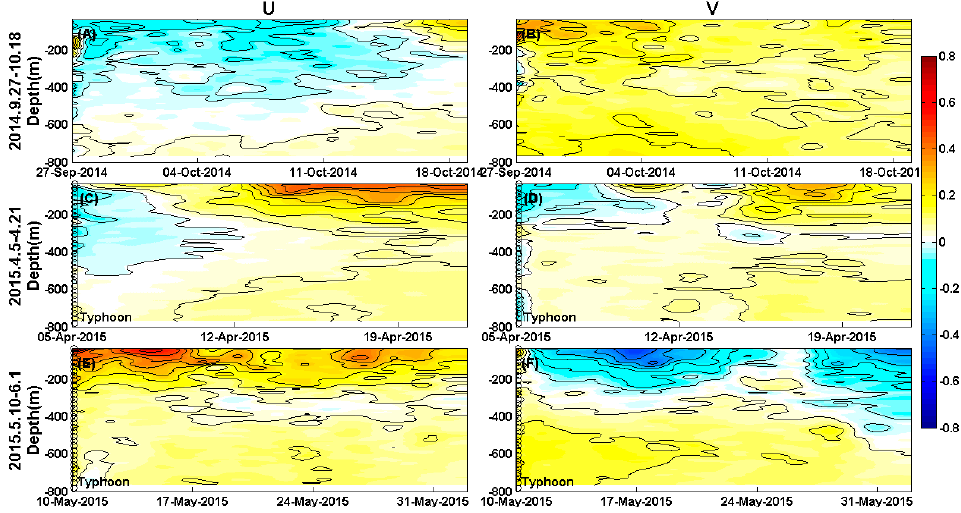
Figure 7. Time evolution of the cross-track component of the low-pass filtered ( σ smaller than 1/72 h − 1 ) ( A , C , E ) eastward and ( B , D , F ) northward ocean currents (m s − 1 ) at 40–800 m deep. The background current is shown in ( A , B ). The second is shown in ( C , D ). The third is shown in ( E , F ). The horizontal axis of the figure is time. The vertical axis is the water depth with the unit m. The black circles indicate the times the typhoons were closest to the